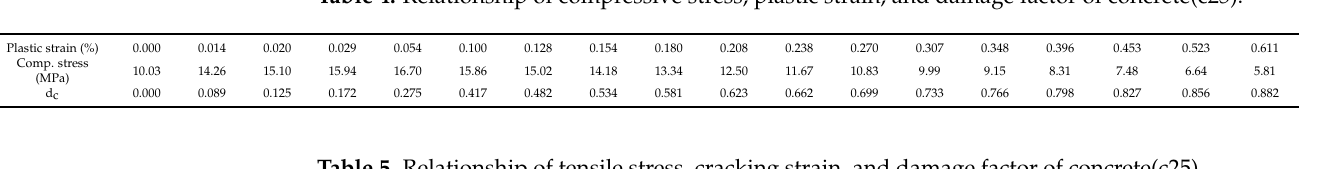
Table 5. Relationship of tensile stress, cracking strain, and damage factor of concrete(c25).